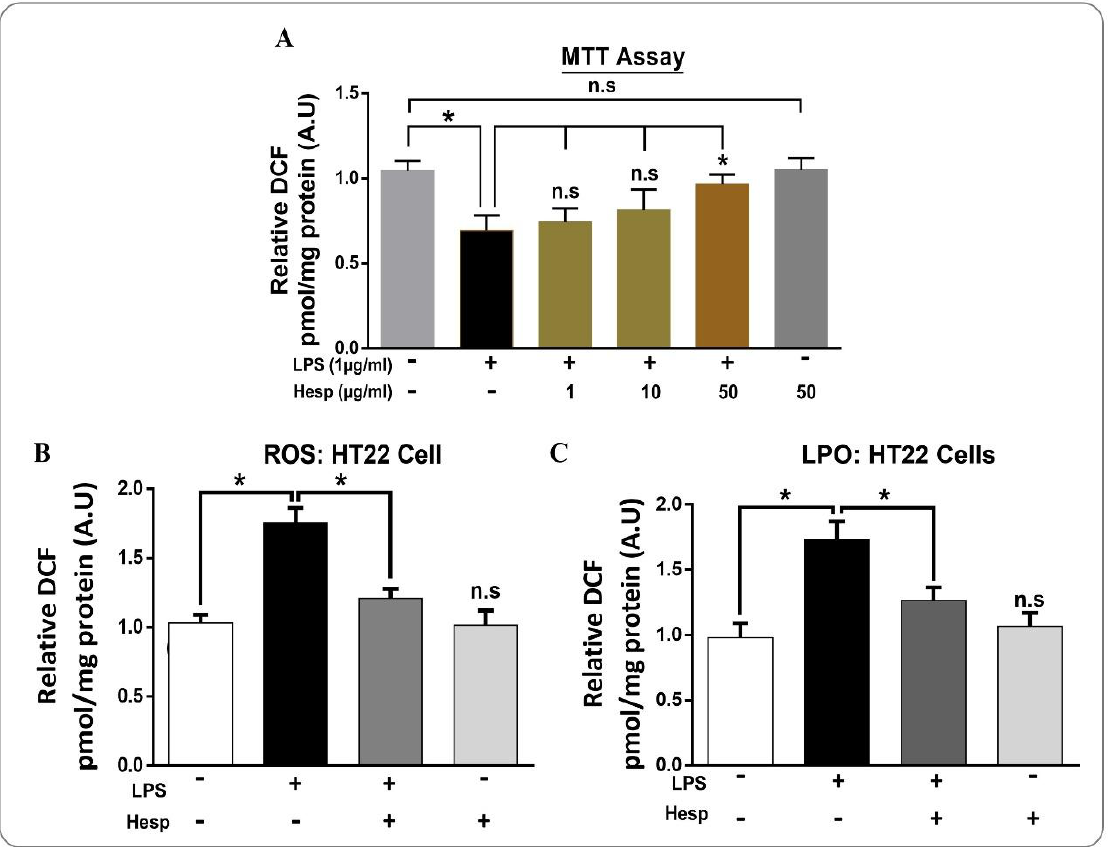
Figure 6. The protective effects of hesperetin in LPS-treated in HT-22 cells: ( A ) the MTT assay conducted in HT-22 cells representing the cell viability in different treated groups (number of experiments = 3); ( B , C ) Analysis of the ROS generation and LPO production in HT-22 Cells. The data are shown as the mean ± SEM of triplicate wells for in vitro experiments are representative of three independent experiments, * p ≤ 0.05.